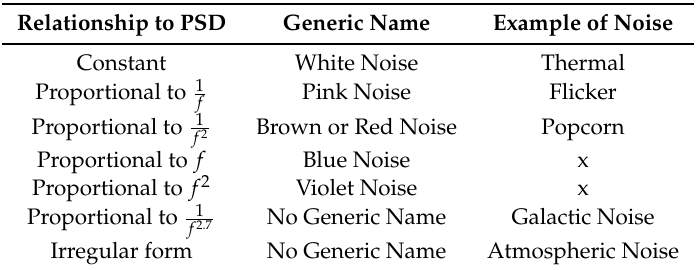
Table 1. Classification of noise according to the power spectral density.